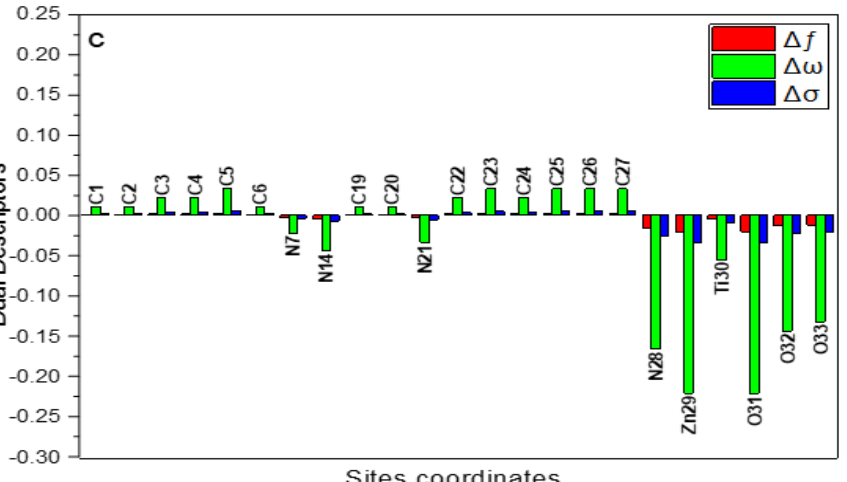
Figure 10. Graphical demonstration of the dual descriptors for the most efficient locations of the examined ZnTiO@PANi compound.